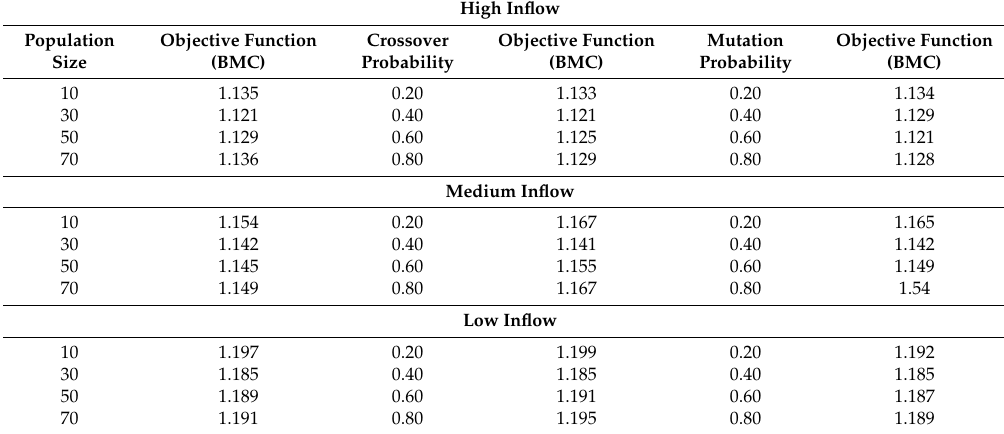
Table 5. Sensitivity analysis for